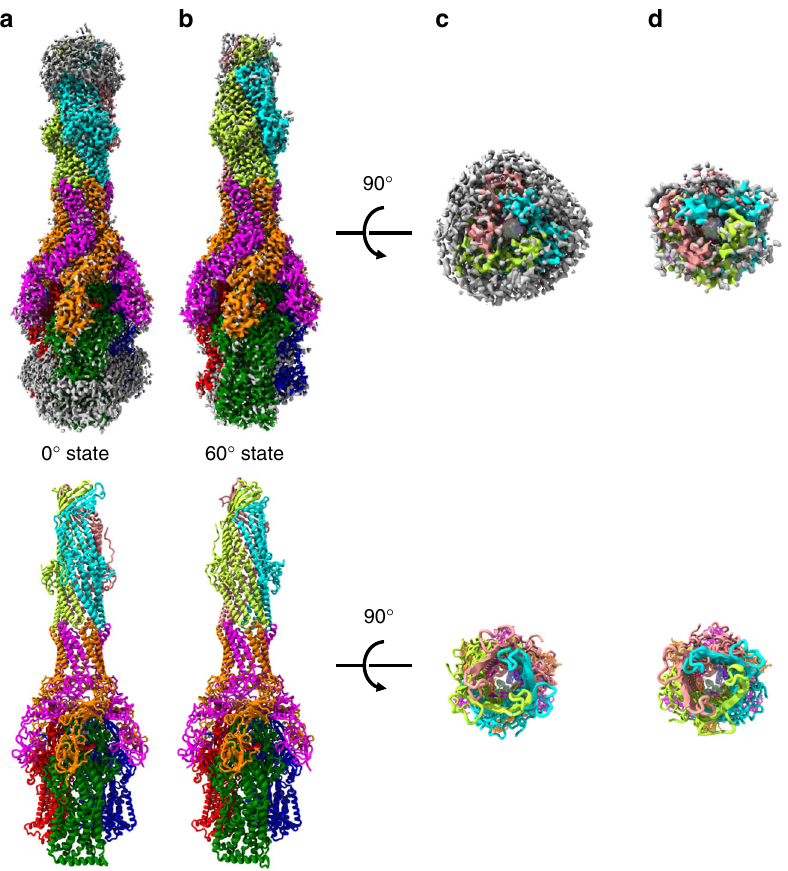
Fig. 1 Overall structure of MexAB – OprM. Single-particle cryo-EM reconstruction (top) and model of MexAB – OprM (bottom) in the 0° state ( a ) or 60° state ( b ) viewed from the periplasmic space ( a , b ) or from the outside the cell ( c , d ). The OprM protomers are colored in cyan, salmon, and lemon. MexA protomers are colored in magenta (SC protomer) or orange (LC protomer). MexB protomers in the Access, Resting, and Extrusion states are colored in green, blue, and red, respectively